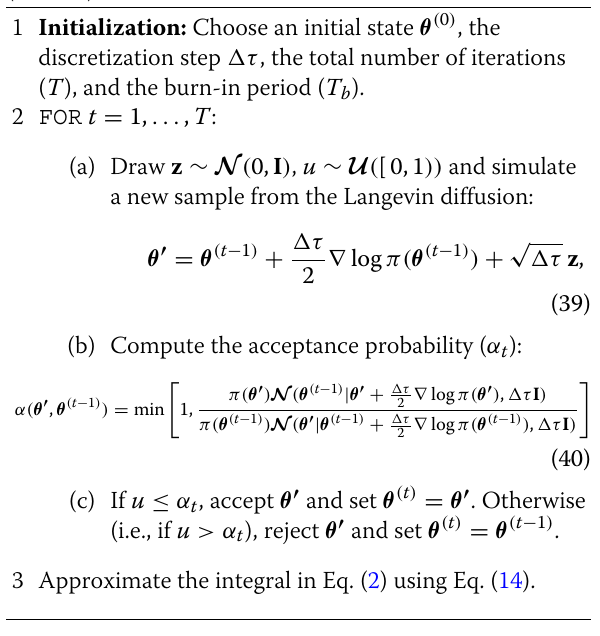
Algorithm 15 Metropolis adjusted Langevin